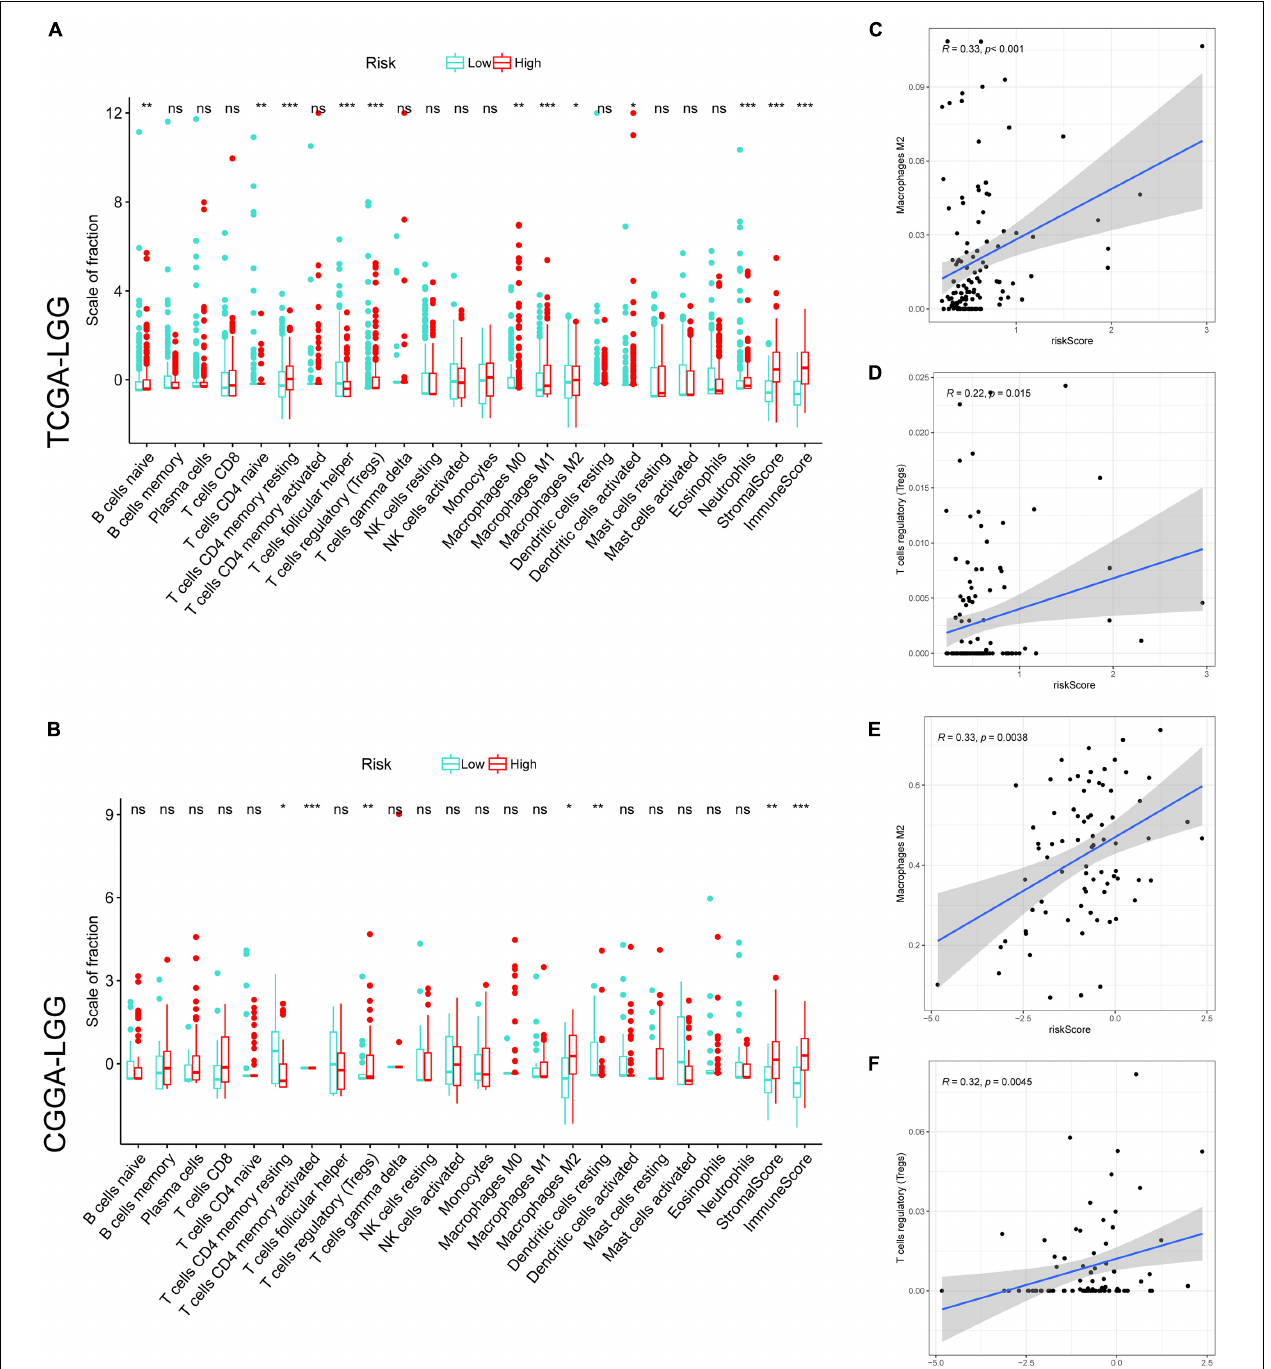
FIGURE 5 | The correlation between tumor-infiltrating immune cells (TIICs) and GSRS. Difference analysis of 22 kinds of an abundance of TIICs, immune score, and stromal score in low and high-risk groups in training (A) and validation sets (B) . Spearman’s correlation analysis between risk score and M2 macrophages, regulatory T cells (Tregs) in TCGA (C,D) and CGGA cohorts (E,F) , each dot plot represents a subject, and the correlation is fitted into a straight blue line. R , rho; *** p < 0.001, ** p < 0.01, * p < 0.05.